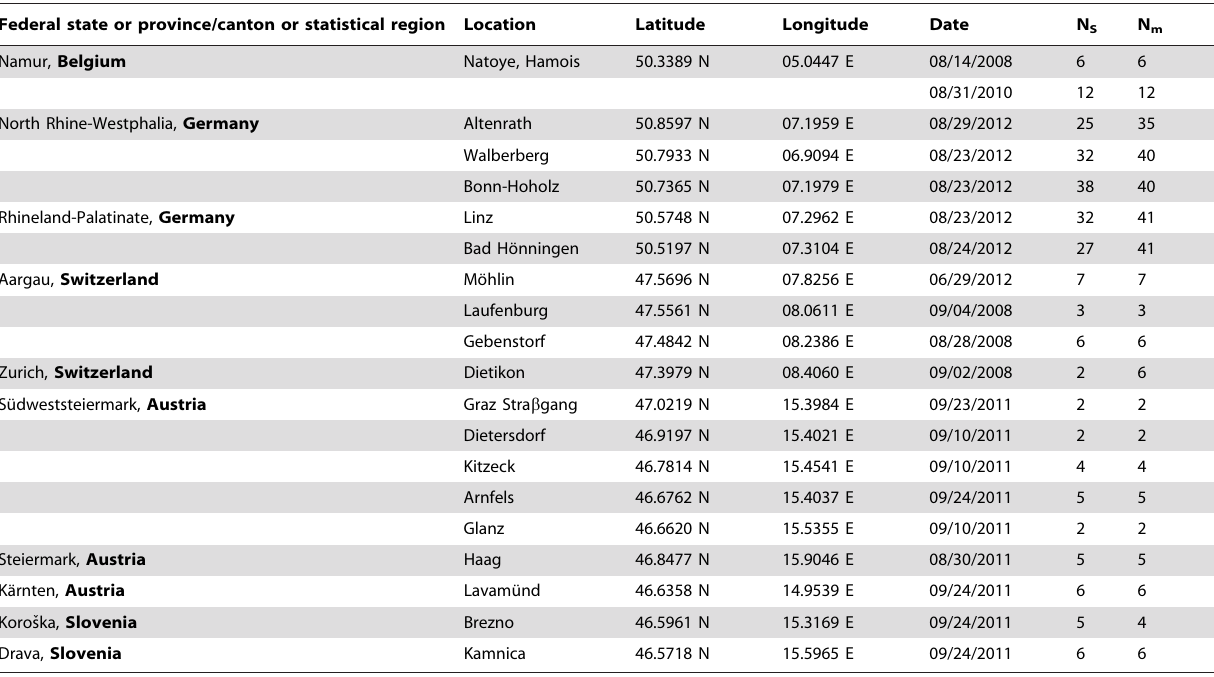
Federal state or province/canton or statistical region